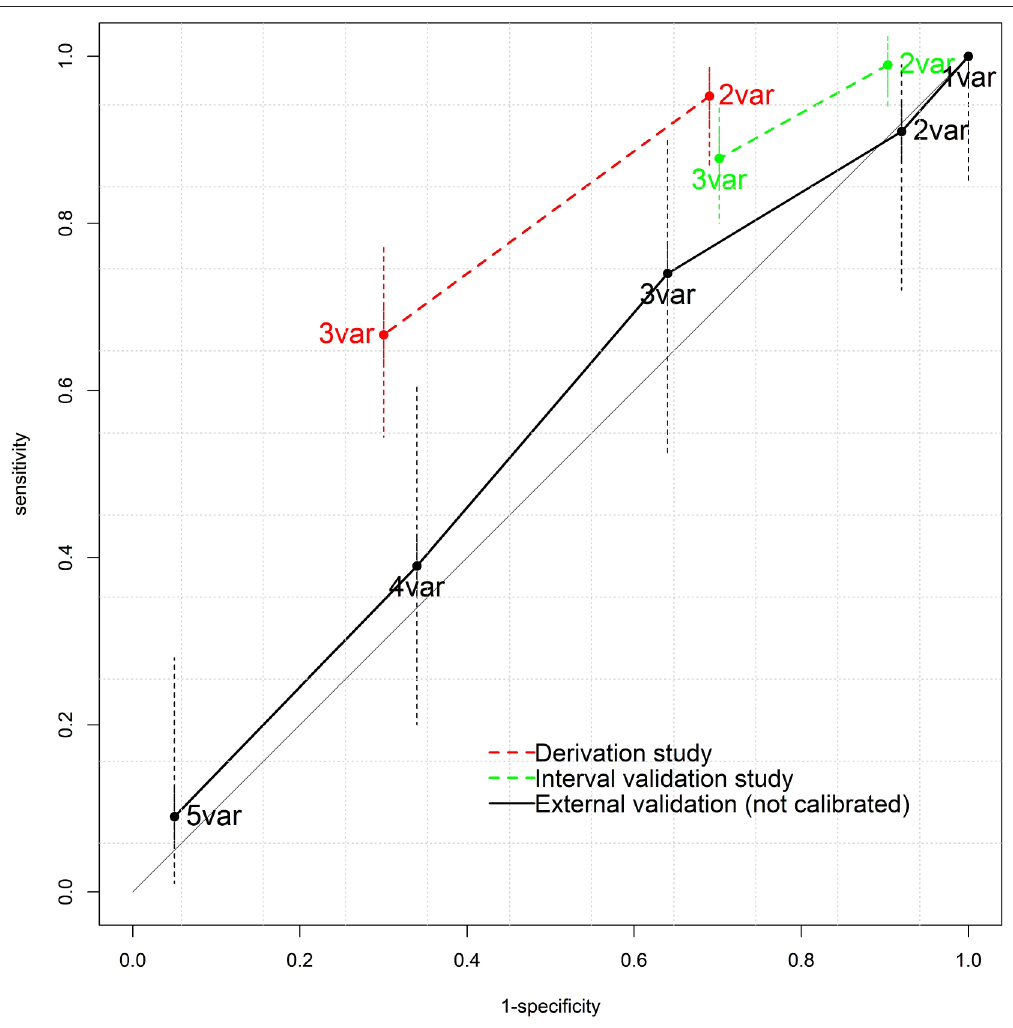
Figure 3 Receiver operating characteristic (ROC) plot of the Gorelick score for urinary tract infection in children aged <2 years. ROC plot showing sensitivity versus 1- specificity. var =